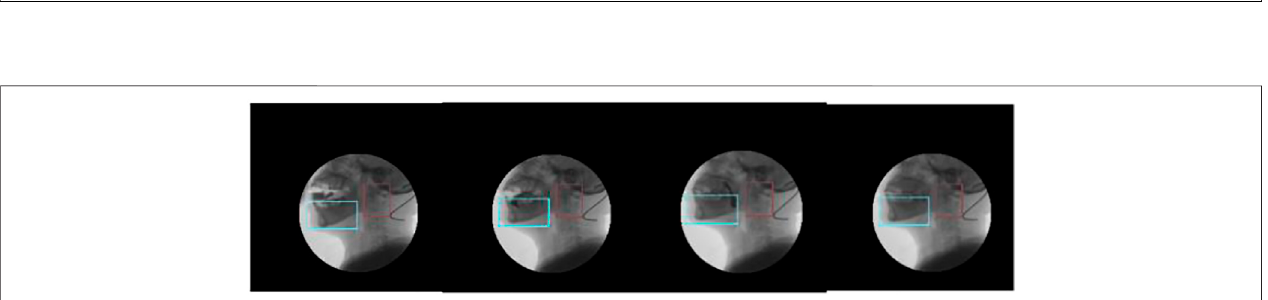
FIGURE10| Filteringresults.(1)Theswallowingstageoftheoralcavity;(2)thetrackingtargetisthepalate;and(3)Haveobviousocclusion;(4)Thetargetisnotlost; (5)and(6)Occlusionoccursagain;Occlusionandforwardleaning;(8)and(9)Bariummealinterference;(10)and(11)Bariummealisswallowedintothethroat;(12)Endof swallowing.